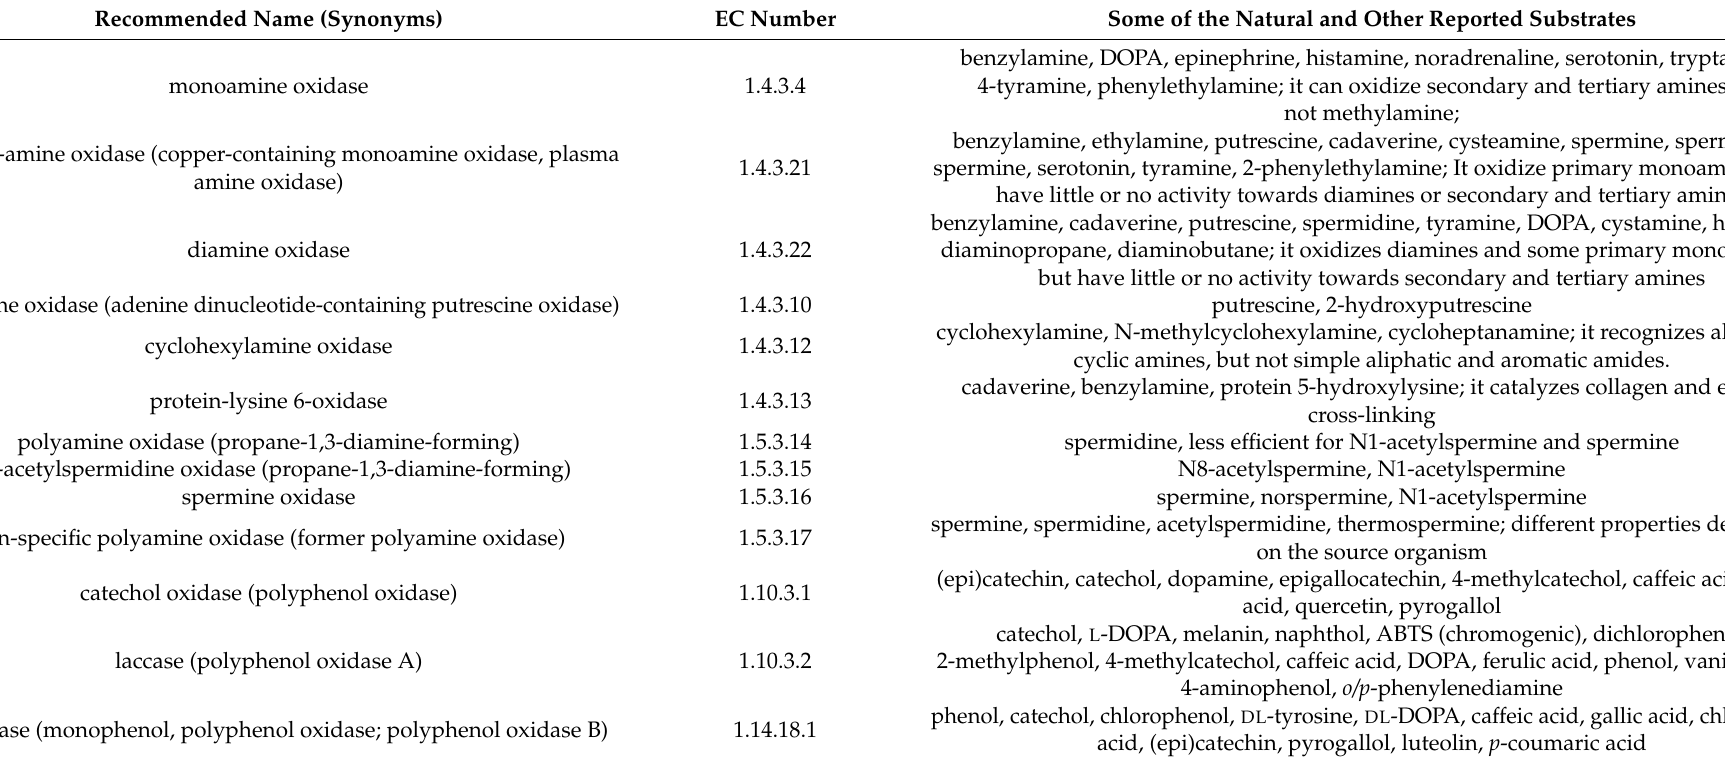
Table 1. A selection of reported substrates for different available amine and phenol oxidases compiled from BRENDA enzyme database (www.brenda-enzymes.org, accessed on 28 March 2021) [20]. Benzylamine is used as artificial substrate for measurement of the activity for several oxidases, hence its wide